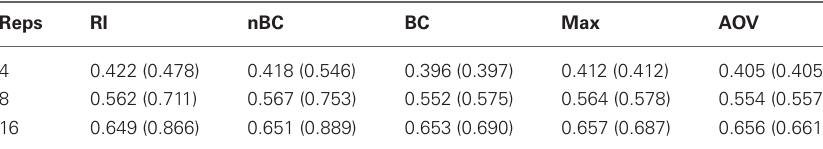
Table 4 | Power for test of ABC in 2 × 2 × 2 design, Adjusted (Raw) p -values.